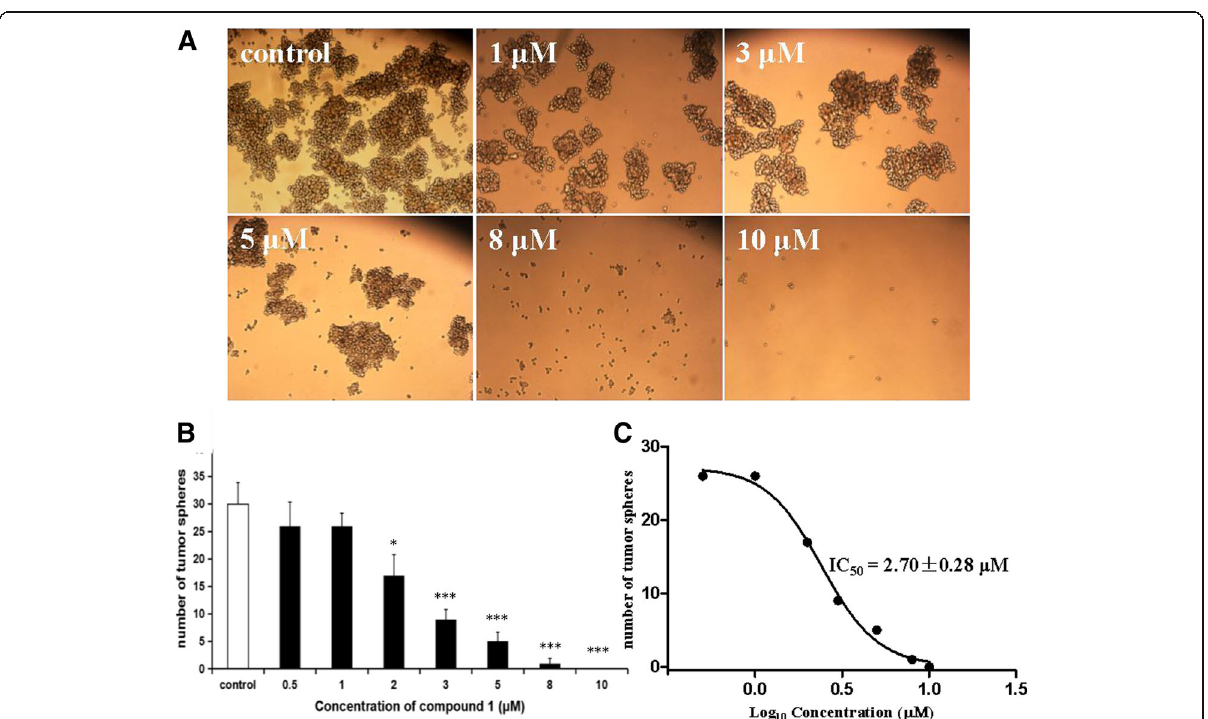
Fig. 4 2-Ethoxystypandrone (1) inhibited self-renewal, cell growth and the tumorsphere formation of HCC CSCs in dose-dependent manner. a . HCC CSCs were treated with 2-ethoxystypandrone (1) at the indicated concentration for 72 h. b . Number of tumorspheres after being treated with 2-ethoxystypandrone ( 1 ) at the indicated concentration for 72 h. Values are means + SEM, * p < 0.05 and *** p < 0.001, compared to control group. One-way ANOVA was used for statistical analysis by SPSS 19.0 software. c . The growth curve of the tumorspheres after being treated 2- ethoxystypandrone (1) at the indicated concentration for 72